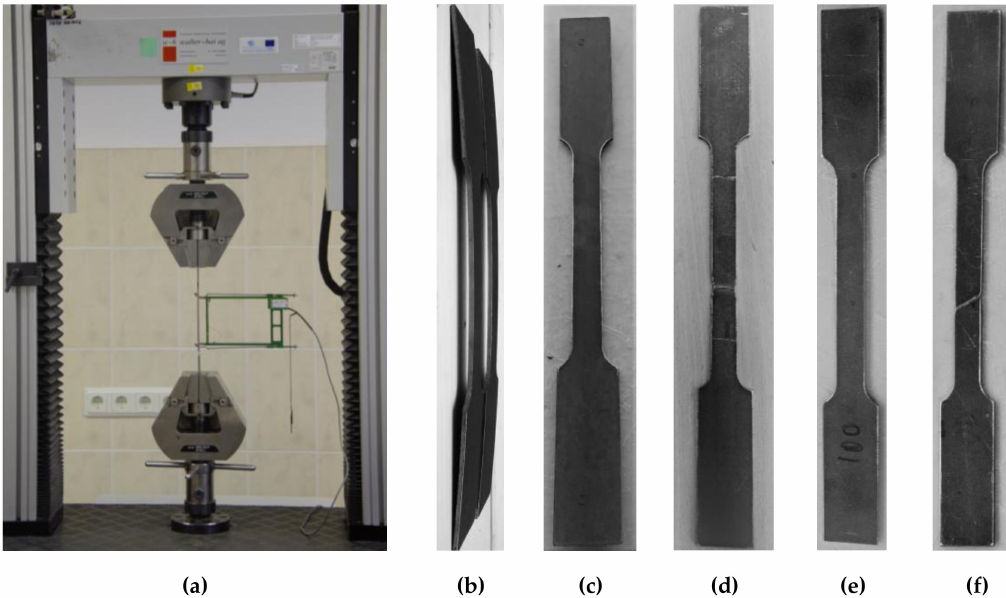
Figure 1. Tensile tests of the steel coupons: ( a ) test setup; ( b ) a deformed shape normal-strength steel (NSS) coupons cut from a straight square hollow section (SHS) profile; ( c , d ) NSS coupon before and after testing, respectively; ( e , f ) HSS coupon before and after testing, respectively.